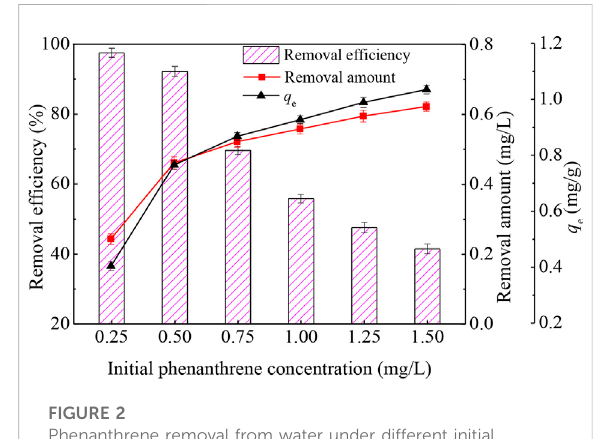
FIGURE 2 Phenanthrene removal from water under different initial phenanthrene